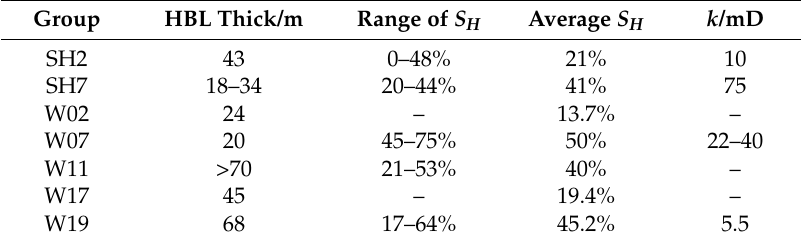
Table 1. The characteristics of the NGH deposits with greater exploitation